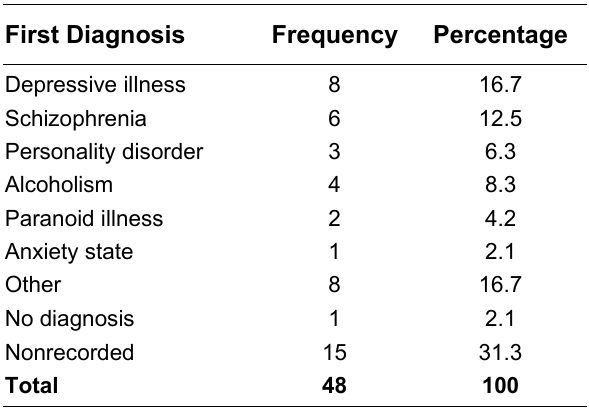
The Sample Distribution of Psychiatric Diagnosis First